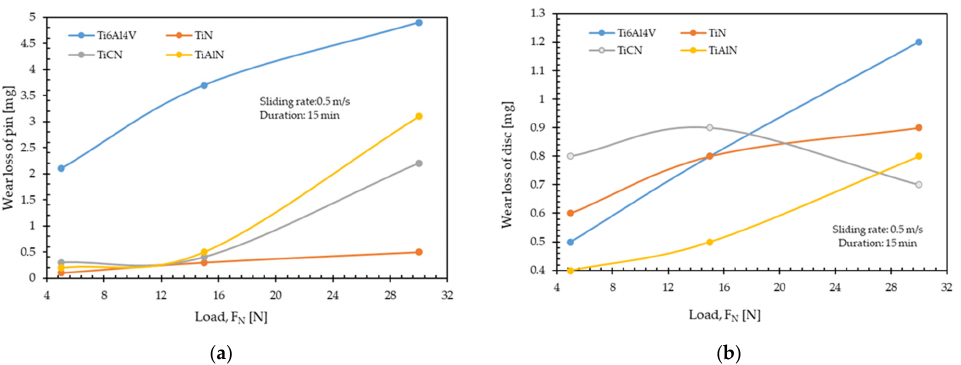
Figure 16. ( a ) The variation in wear loss with load for the pin, ( b ) The variation in wear loss with load for the wearing part(disc).